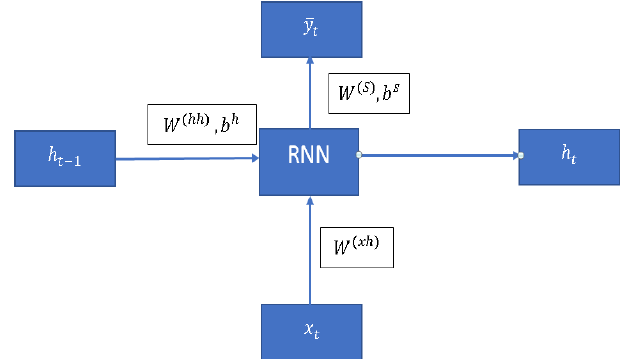
Figure 1. Weights and biases that are fed into the Recurrent Neural Network.